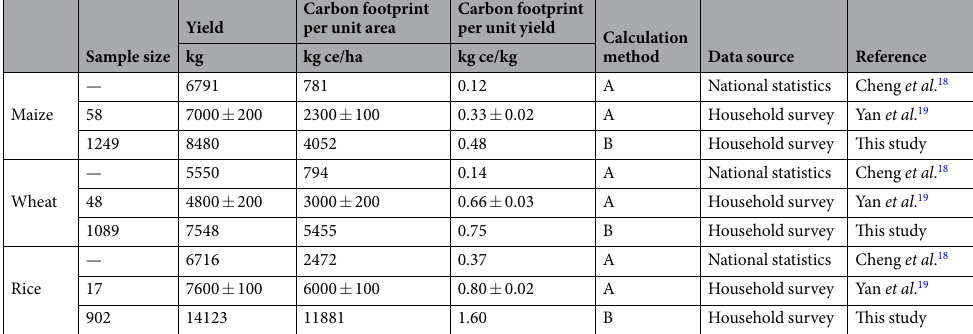
Table 2. Carbon footprint per unit area and carbon footprint per unit yield from different studies of grain crop production in China. Note: “A” indicates the upstream emission + field emission (no manure), and “B” indicates the upstream emission + field emission + straw-burning emission after harvest.